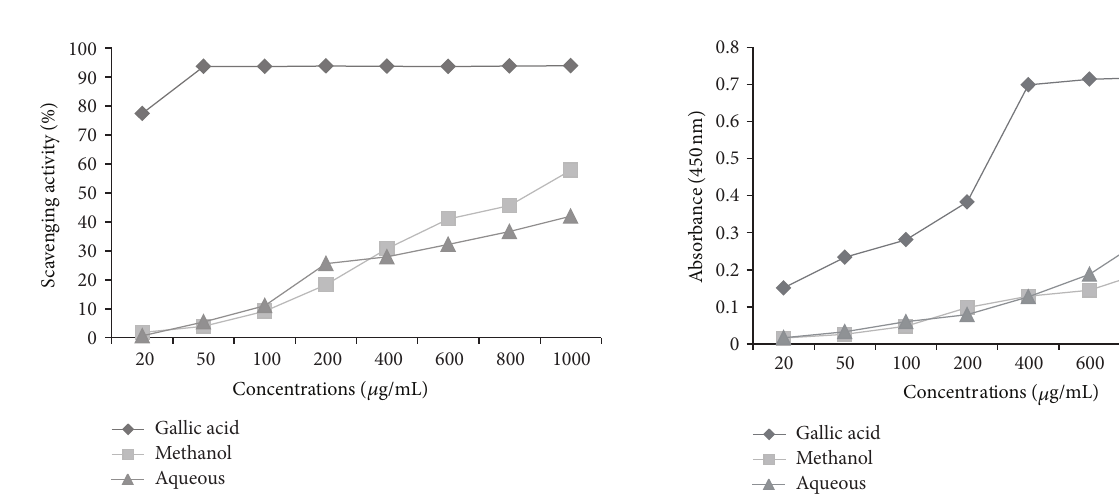
Figure 3: Antioxidant activity of different extracts of P. aculeata L. leaves and standard (gallic acid) by using CUPRAC assay.